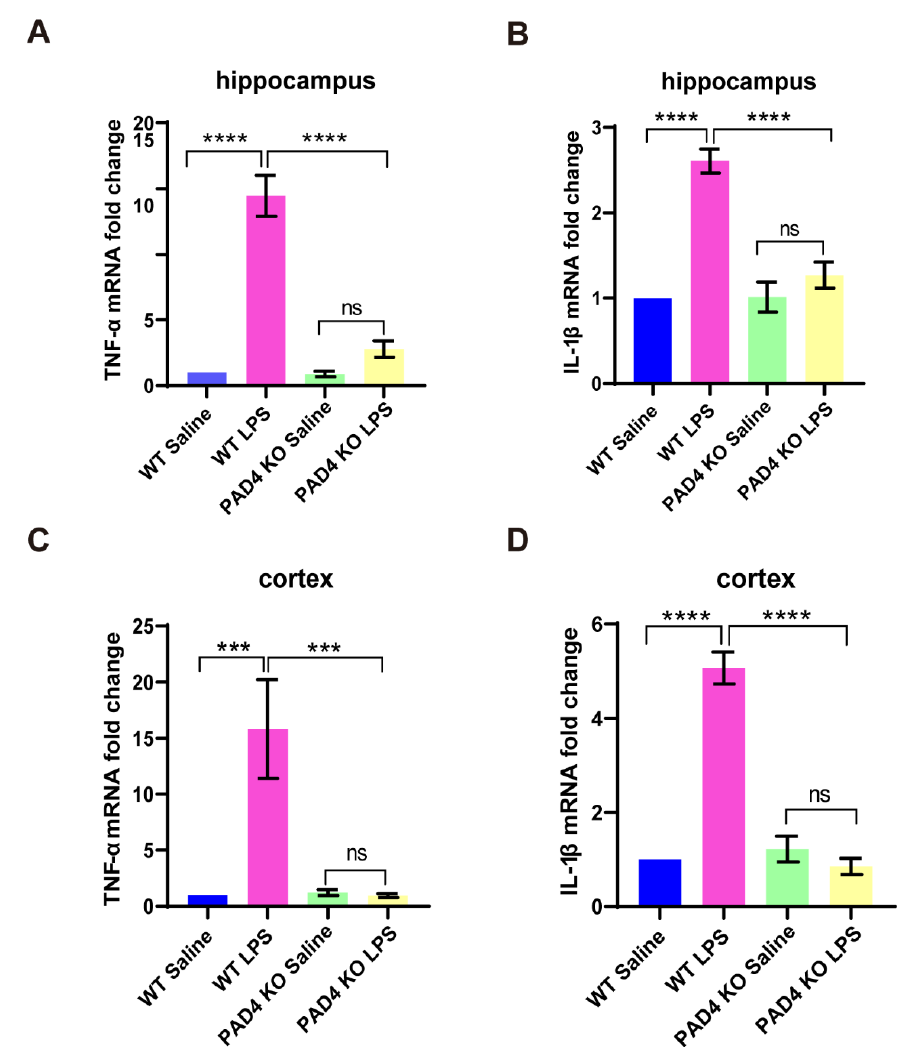
Figure 4. PAD4 knockout attenuates the neuroinflammation induced by LPS. ( A , B ) The mRNA of TNF- α and IL-1 β in hippocampus after LPS or saline treatment. ( C , D ). The mRNA level of TNF- α and IL-1 β in cortex after LPS or saline treatment. Data were expressed mean ± SEM. *** p < 0.001, **** p < 0.0001. n = 3. WT Saline: n = 4; WT LPS: n = 4; PAD4 KO Saline: n = 3; PAD4 KO LPS: n = 5 .